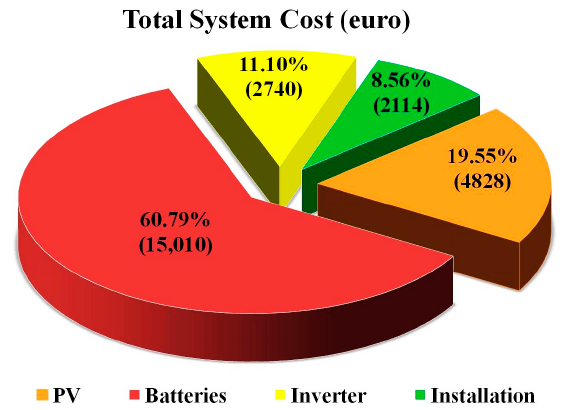
Figure 11. Total system cost breakdown.